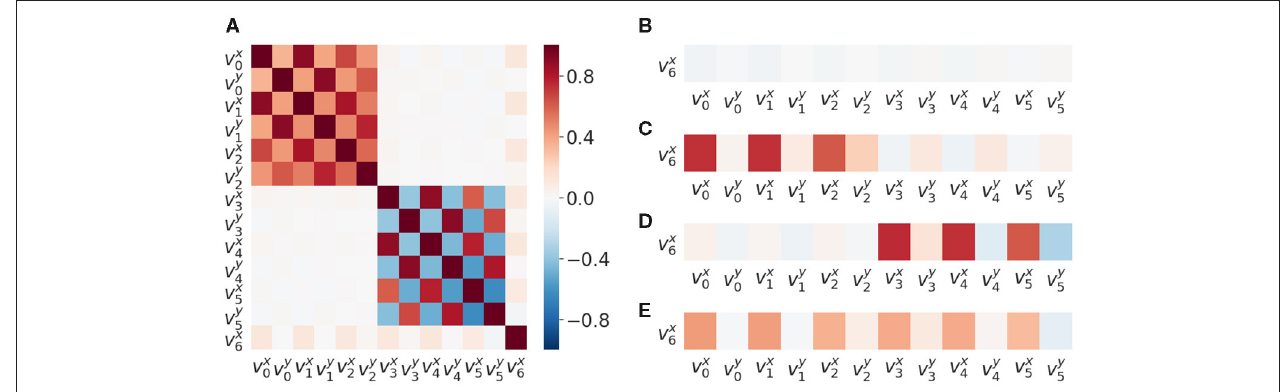
FIGURE 2 | Velocity correlation matrices of SIPs.. (A) Velocity correlation matrix of all the SIPs generated from 50,000 random SM interactions. (B) Correlation between SIP velocities, object velocity v x 6 and arms v x 0 ,..., v x 5 , when there is no contact (no haptic signal active). (C) Correlation between object and arms SIP velocities when there is contact between the lower arm and the object. (D) Correlation between object and arms SIP velocities when there is contact between the upper arm and the object. (E) Correlation object and arms SIP velocities when there is contact between the object and either arm.